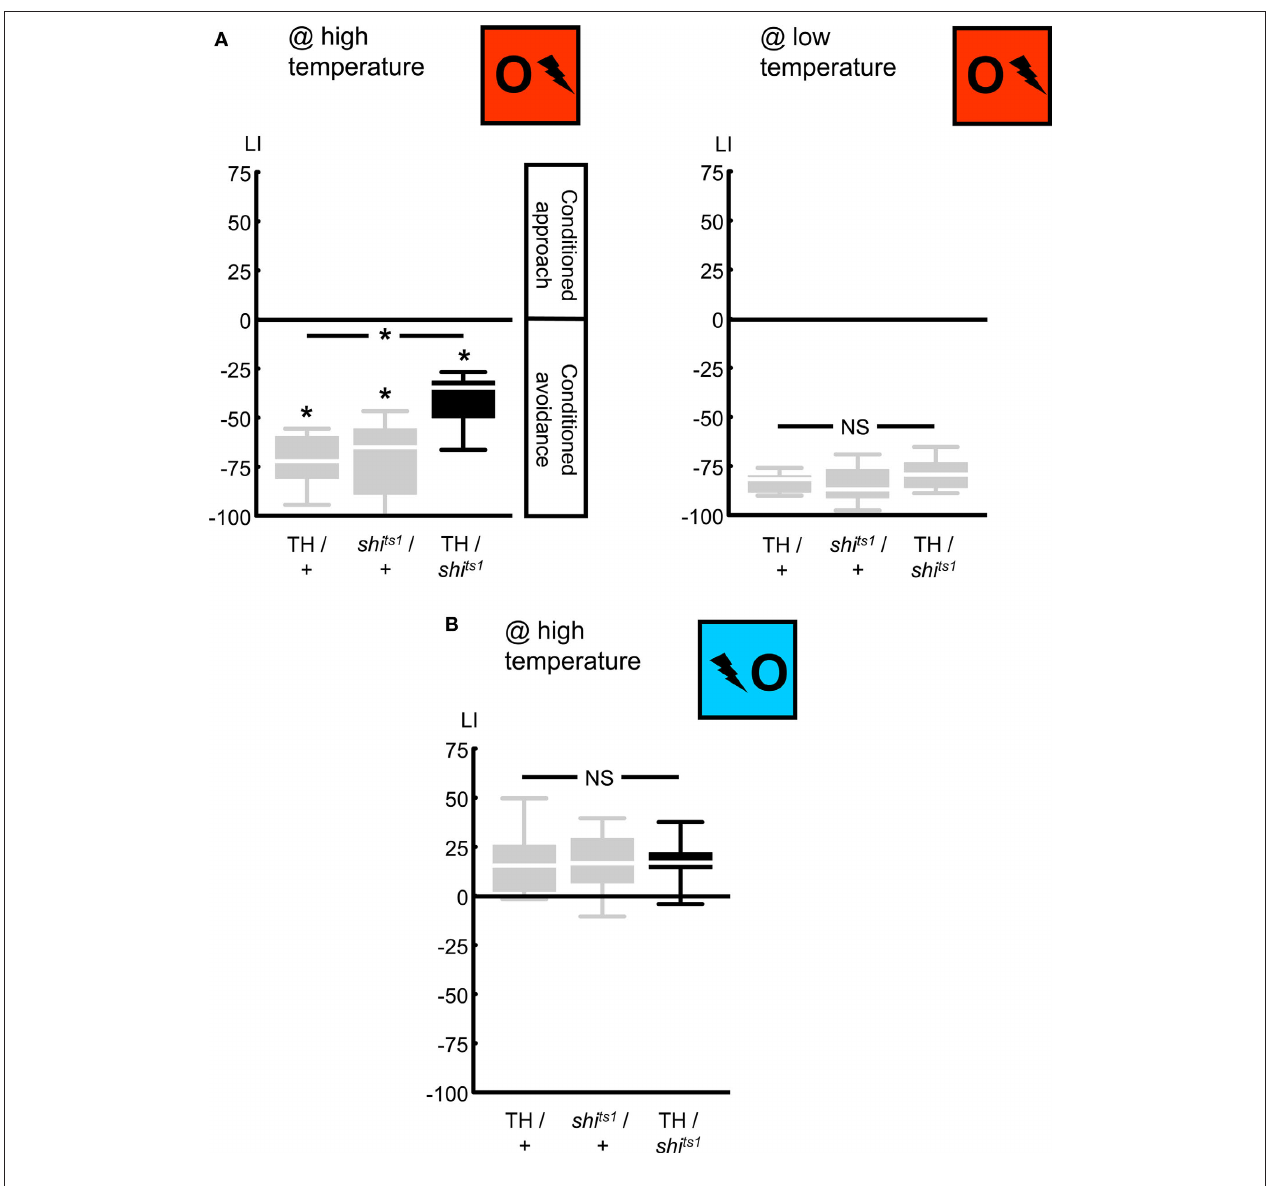
P > 0.05 while comparing between genotypes. While comparing scores of each genotype to 0 * P < 0.05/3, to keep the experiment-wide error-rate at 5% (i.e., Bonferroni correction). Sample sizes were N = 8, each in (A) and 13, each in (B) . Box plots show the median as the midline; 25 and 75% as the box boundaries and 10 and 90% as